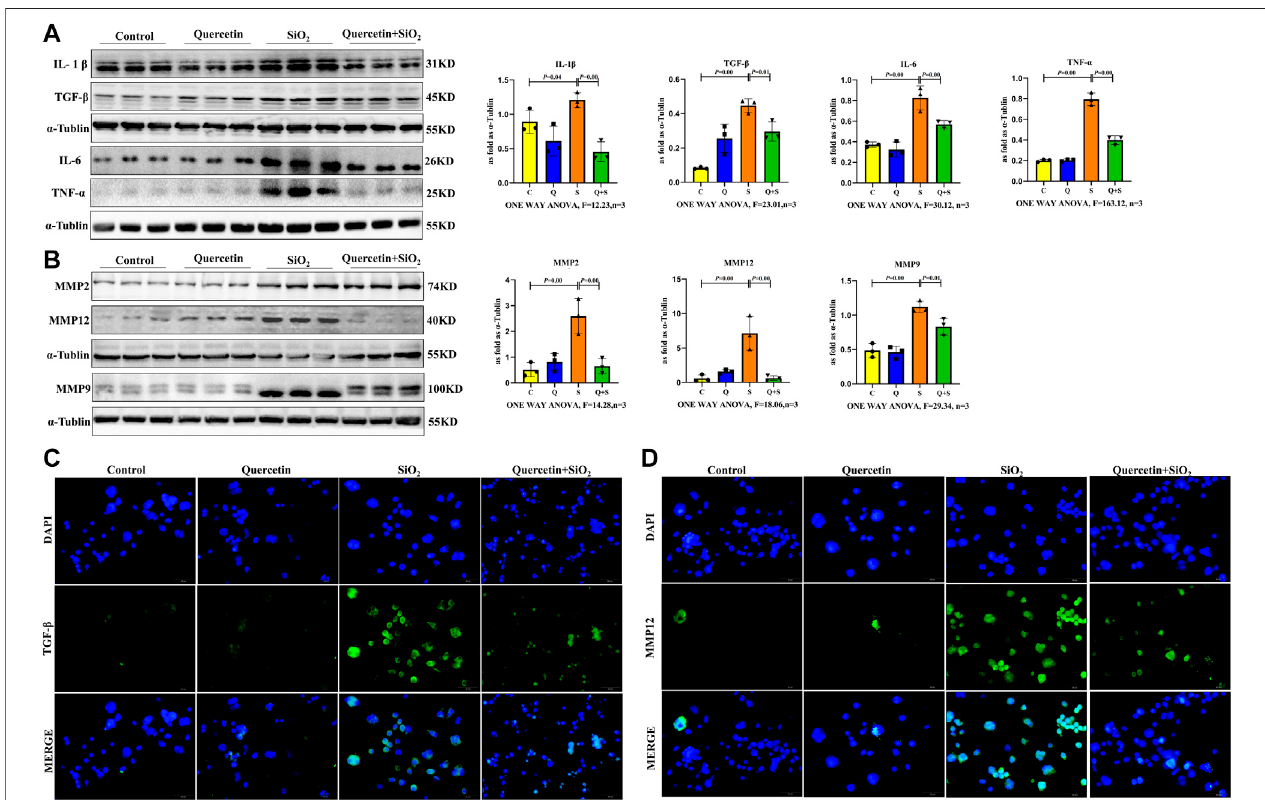
FIGURE7| Elevated fi broticandSASPproteinexpressioninsenescentmacrophages. (A) IL-1 β ,IL-6,TNF- α andTGF- β 1expressionsbywesternblot. (B) MMP2, MMP9andMMP12expressionsbywesternblot. (C) Immuno fl uorescencestainingforTGF- β 1. (D) Immuno fl uorescencestainingforMMP12.Dataarepresented asthe mean ± SD. n = 3 per